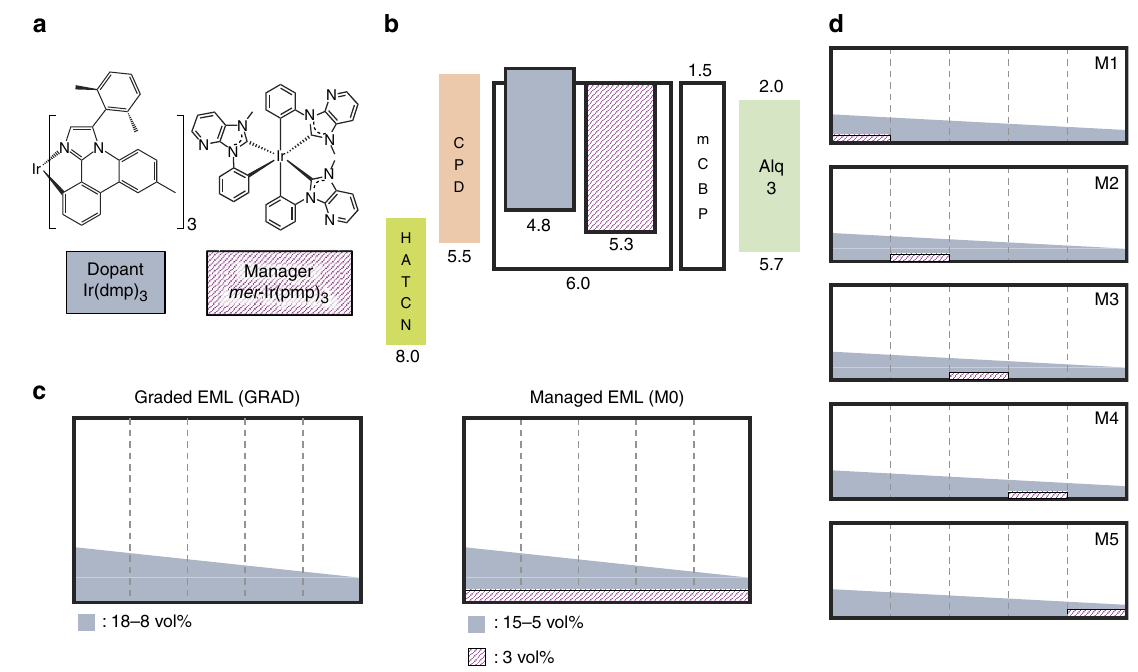
Figure 2 | Energy and doping schemes of the PHOLEDs. ( a ) Molecular formulae of Ir(dmp) 3 and mer -Ir(pmp) 3 , used for the dopant and the manager, respectively. ( b ) Energy level diagram of the PHOLED with the manager, denoted ‘managed PHOLED’. Numbers in the figure are energies referred to the vacuum level. ( c ) Doping scheme of the 50nm-thick EML for the graded-EML and managed PHOLEDs, denoted as GRAD and M0, respectively. GRAD has the dopant graded from 18 to 8vol% in the mCBP host, while M0 is a similarly graded device but with the 3vol% of the manager replacing the dopant of the same amount, compared to GRAD, to keep the total doping concentration the same for both devices. ( d ) Managed PHOLEDs M1–M5 have selectively doped 10nm-thick zones of the EML. The zones have a manager doping of 3vol% substituting the dopant of the same amount. The other details of the EML are identical to that of